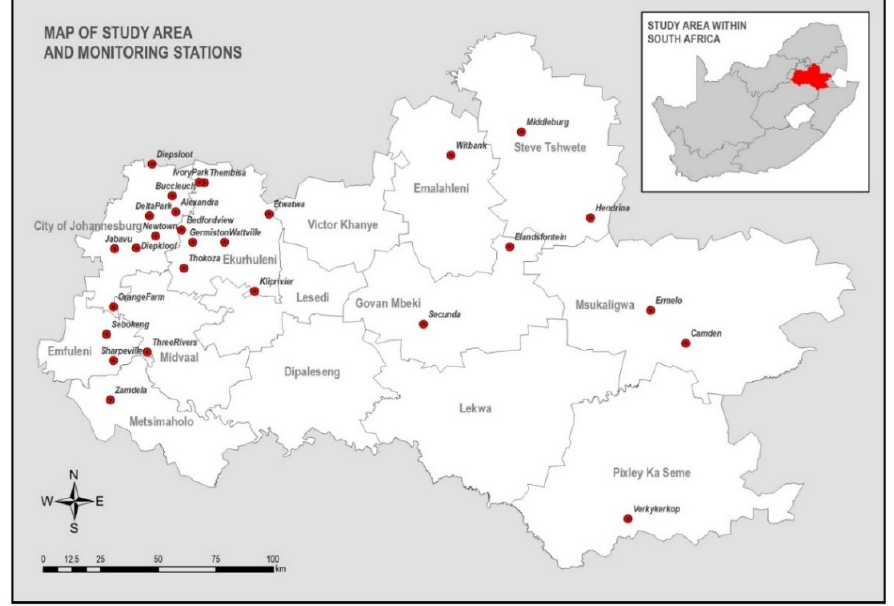
Figure 1. Study area and monitoring stations.